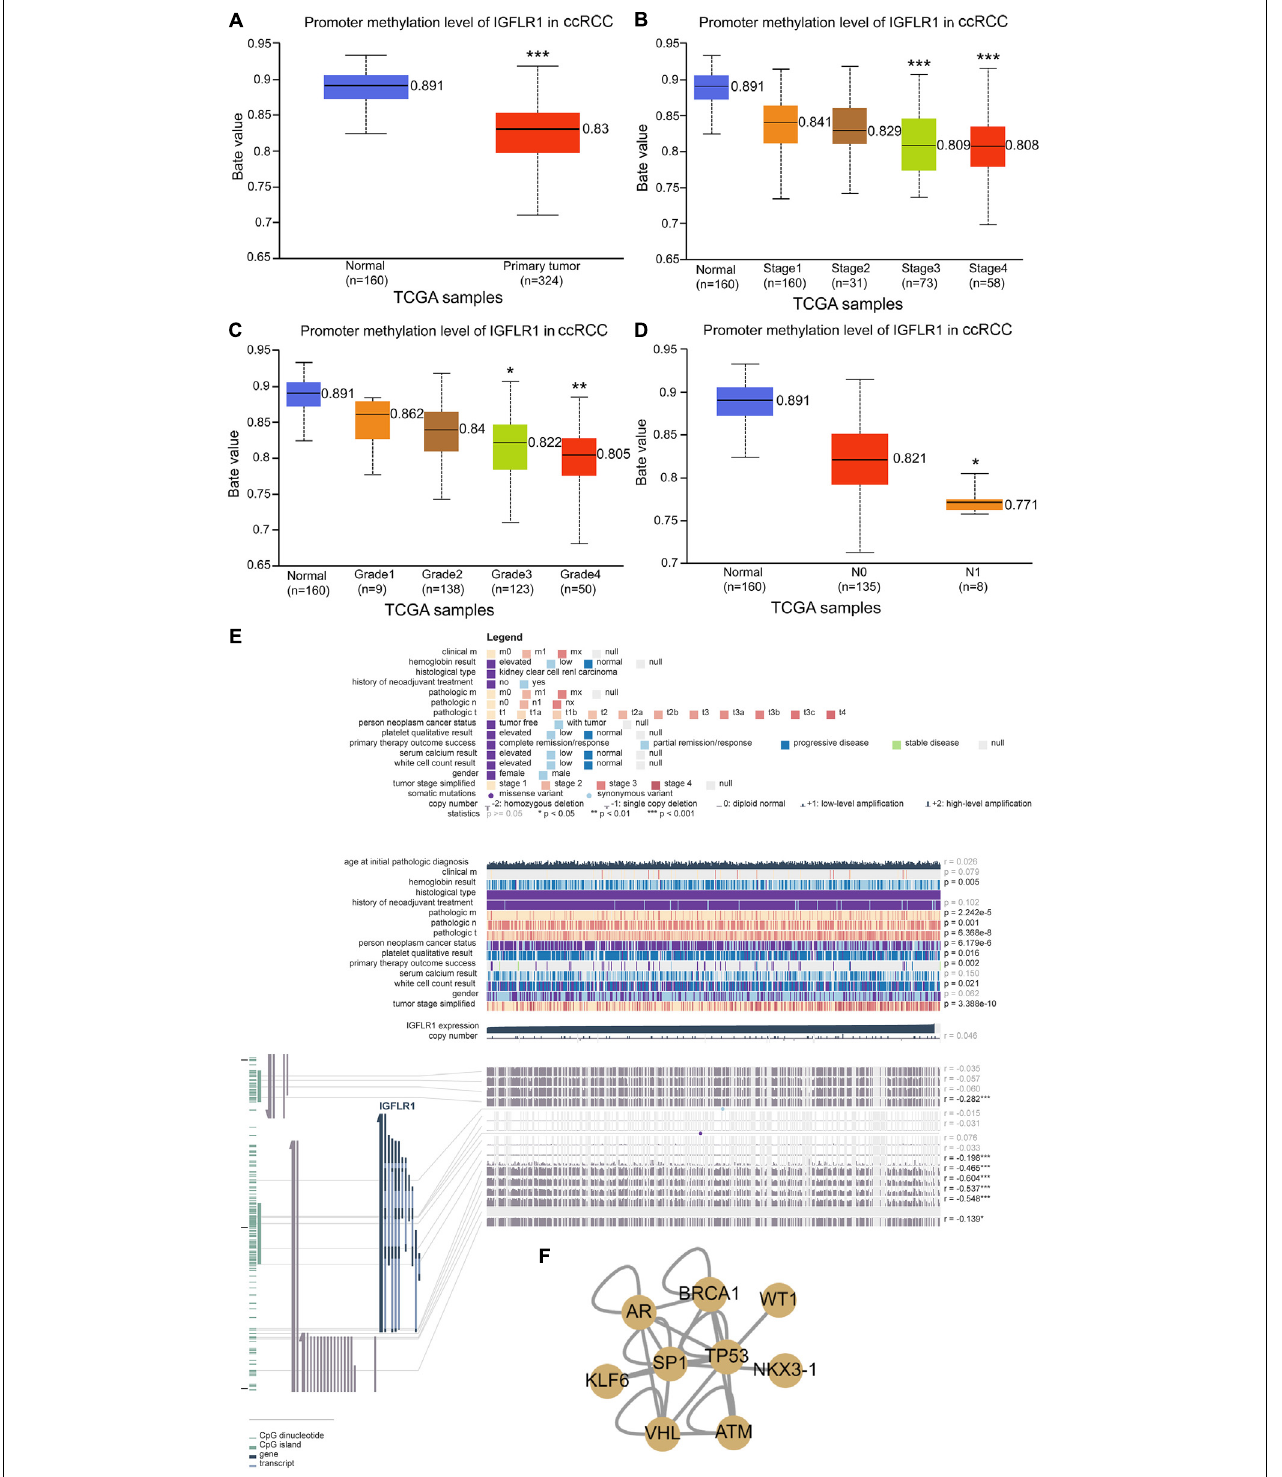
FIGURE 2 | Methylation profile of IGFLR1. (A–D) IGFLR1 promoter methylation level in ccRCC of different sample type, stage, Grade and nodal metastasis status. All the advanced tumors were compared with stage1, Grade1 and N0 tumors. [Note: The Beta value indicates level of DNA methylation ranging from 0 (unmethylated) to 1 (fully methylated). Different beta value cut-off has been considered to indicate hyper-methylation (Beta value: 0.7–0.5) or hypo-methylation (Beta-value: 0.3–0.25)]. (E) The correlation between IGFLR1 expression level and DNA methylation, copy number and clinical data in ccRCC in detail. (F) Transcription factor (TF) regulatory network. (n.s.: not significant, * p < 0.05, ** p < 0.01, *** p <